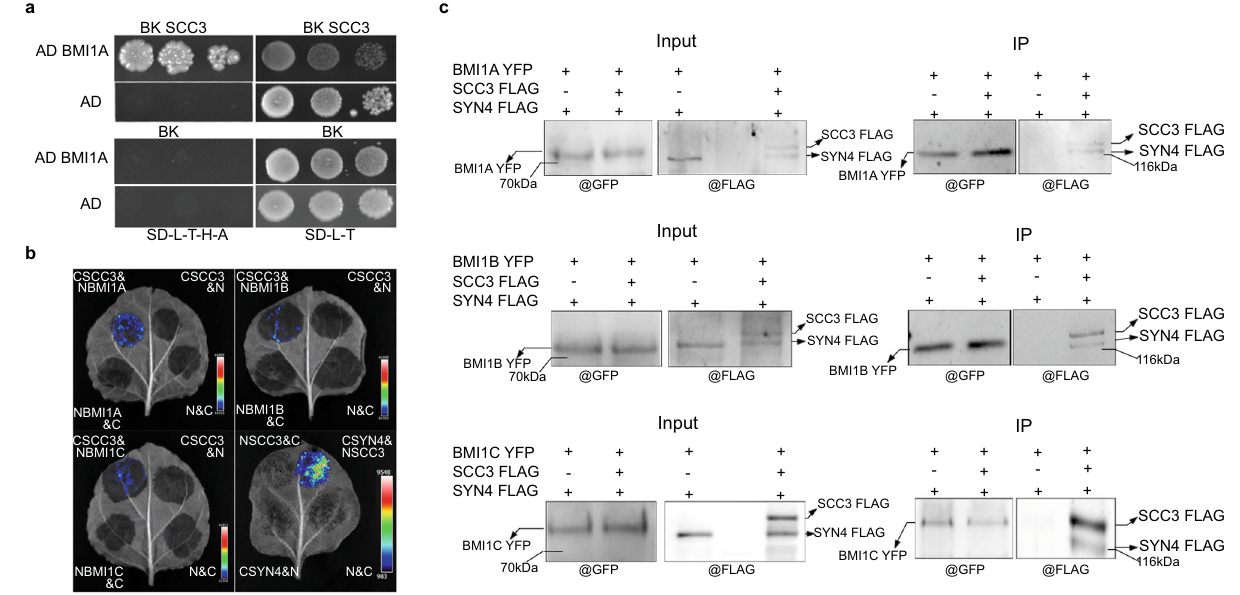
Fig. 1 | AtSCC3 interacts with AtSYN4 and AtBMI1A/B/C. a Yeast two-hybrid assays show thatAtSCC3 interactswith AtBMI1A. b LUC complementationimaging assaysshowthatAtSCC3interactswithAtBMI1A/B/CandAtSYN4.CSCC3orNSCC3 representstheAtSCC3fusedwiththeC-terminalorN-terminalofLUC,respectively. NBMI1A/B/C represents AtBMI1A/B/C fused with the N-terminal of LUC. CSYN4